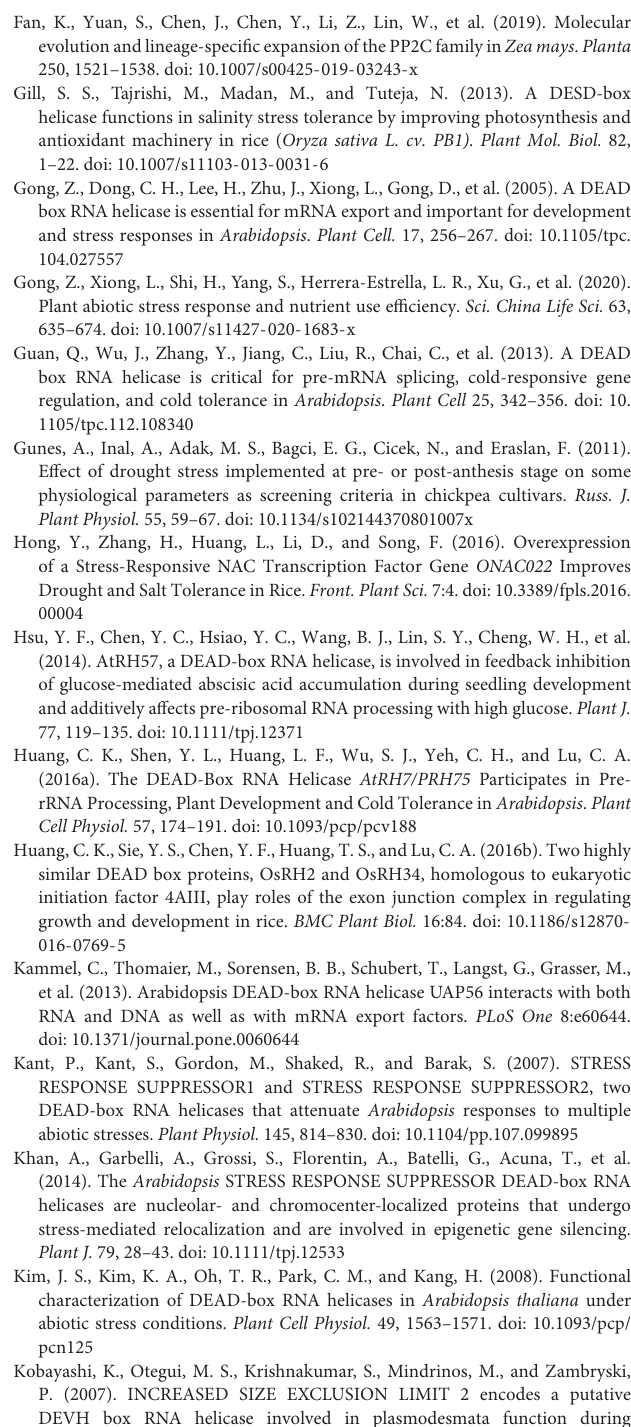
Supplementary Table 6 | Cis -elements in the promoter region of 141 TaDEAD-box genes. Supplementary Table 7 | The TPM values of 141 TaDEAD-box genes from transcriptome data. Supplementary Table 8 | The primers used in this